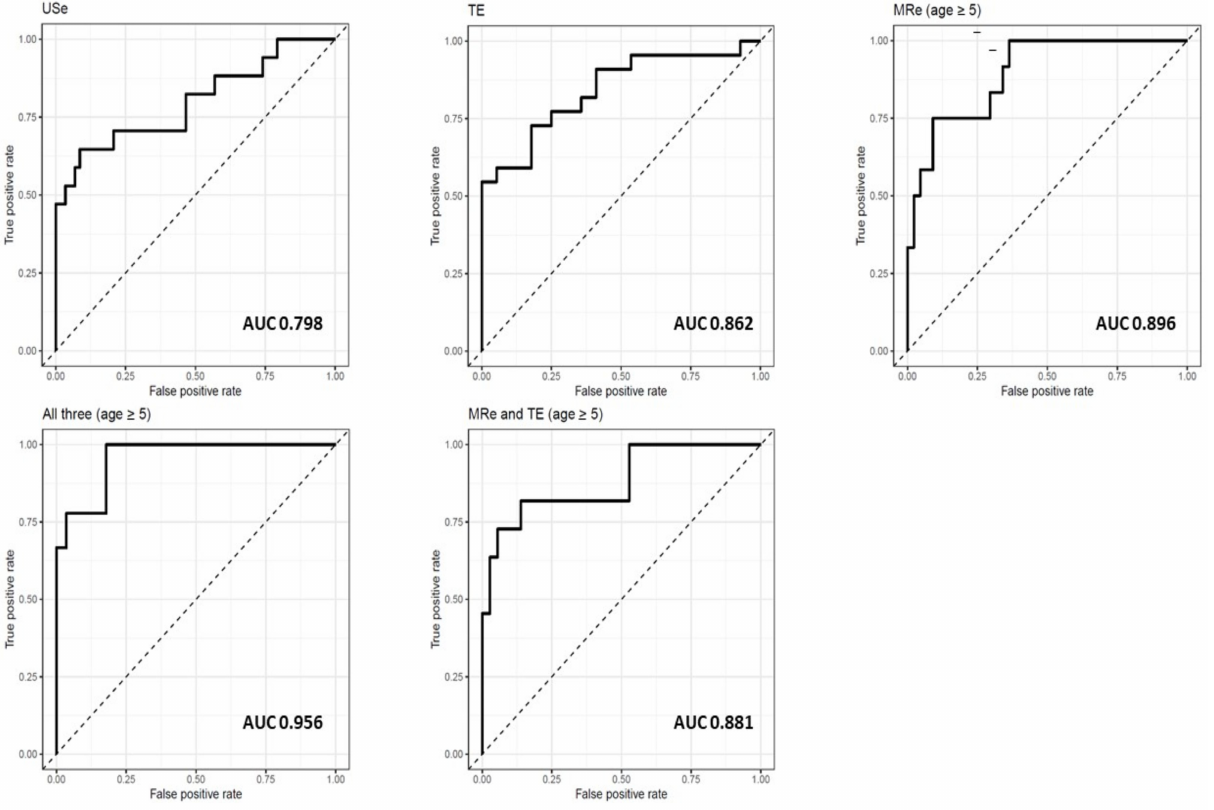
Figure 2. Receiver operating characteristics curves for the complete case